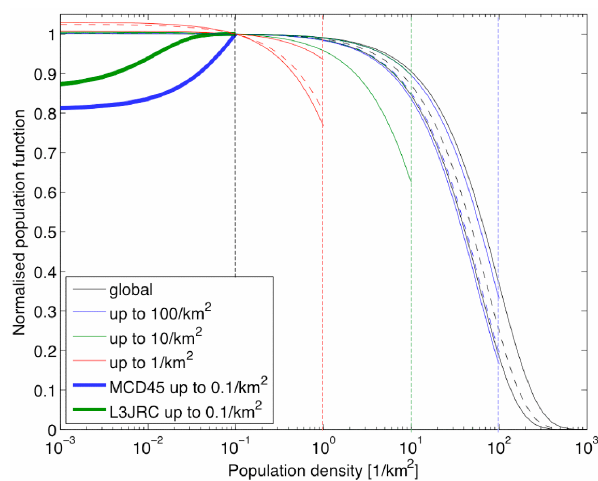
Fig. 6. Effect of human population on fire frequency as a function of population density after optimisation against satellite data for areas. The result of optimisations for grid cells with up to 0.1 peoplekm − 2 (thick lines) are shown separately for each burned-area data product. Here, only two of three optimisations were successful. Optimisations for up to 1, 10, 100 inhabitantskm − 2 or for all population densities are shown as ensembles containing optimisations against all three burned-area data sets used in the analysis (thin lines, of which dashed lines: median, solid lines: 95% confidence range). All functions were normalised to 1 at 0.1 inhabitantskm − 2 . Dashed vertical lines denote the maximum population density for the different optimisations for better visualisation.